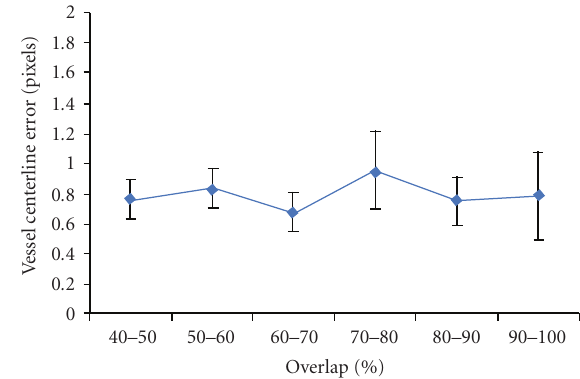
Figure 10: The vessel centerline error measure is plotted against the percentage of image overlap with